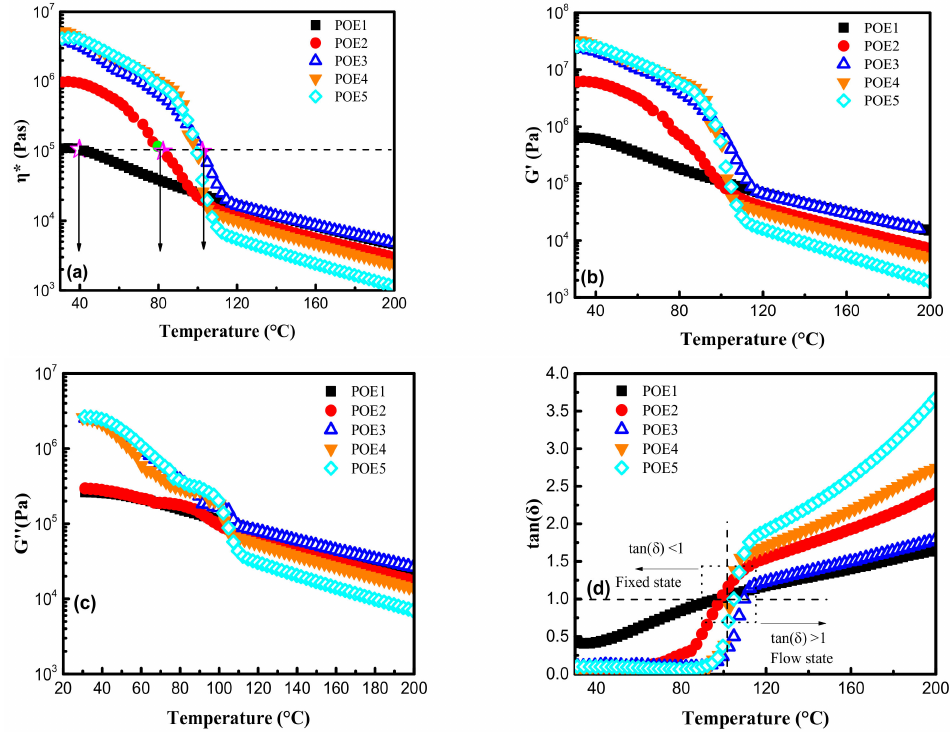
Figure 6. Temperature dependence of ( a ) complex viscosity, η ∗ ; ( b ) storage modulus, G (cid:48) ; ( c ) loss modulus, G (cid:48)(cid:48) ; ( d ) loss angle, tan ( δ ) for POE samples during the temperature-rising sweep